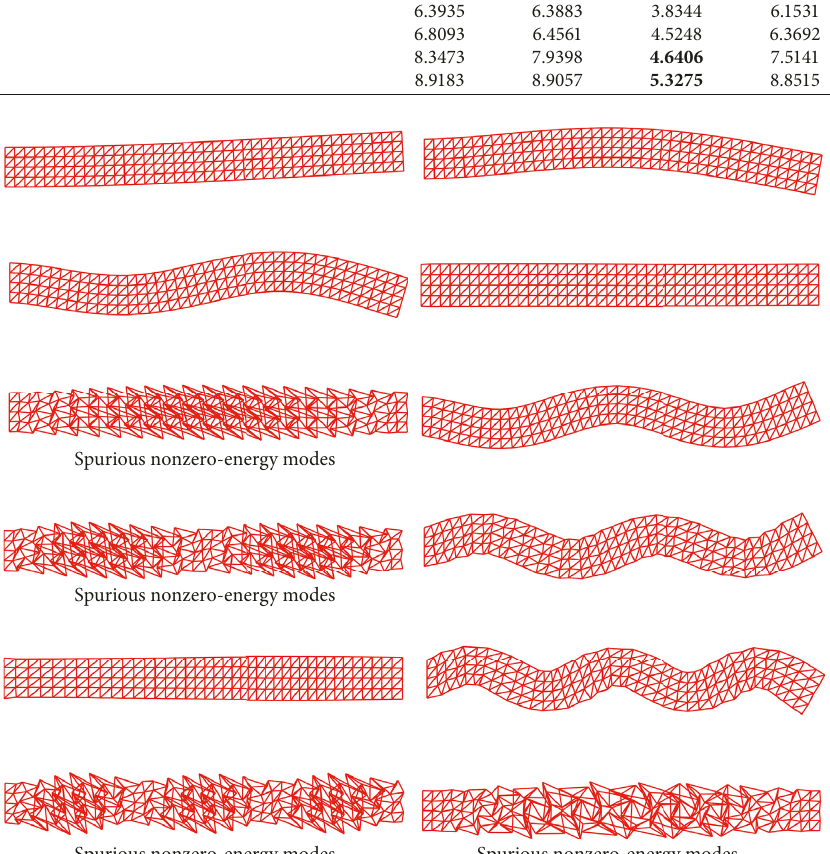
Figure 22: First 12 modes of the cantilever beam by